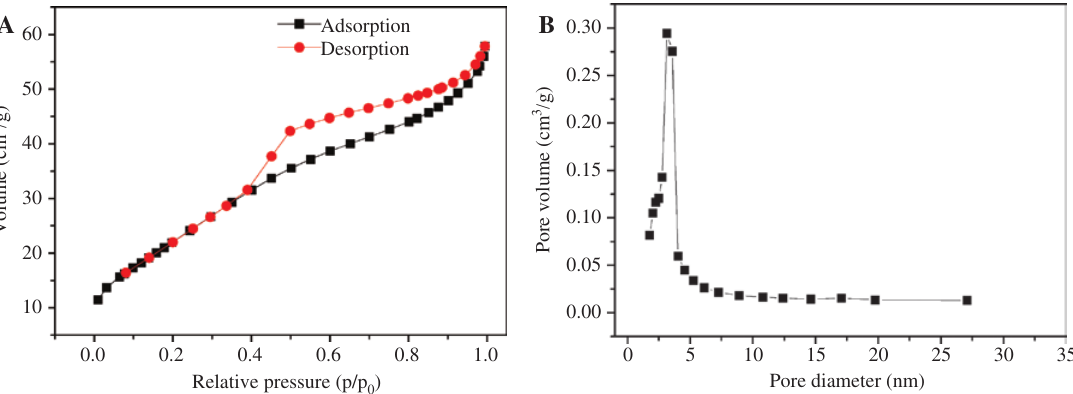
with large surface area of 86.5 m 2 /g and narrow pore distribution has been successful prepared by USP of 2